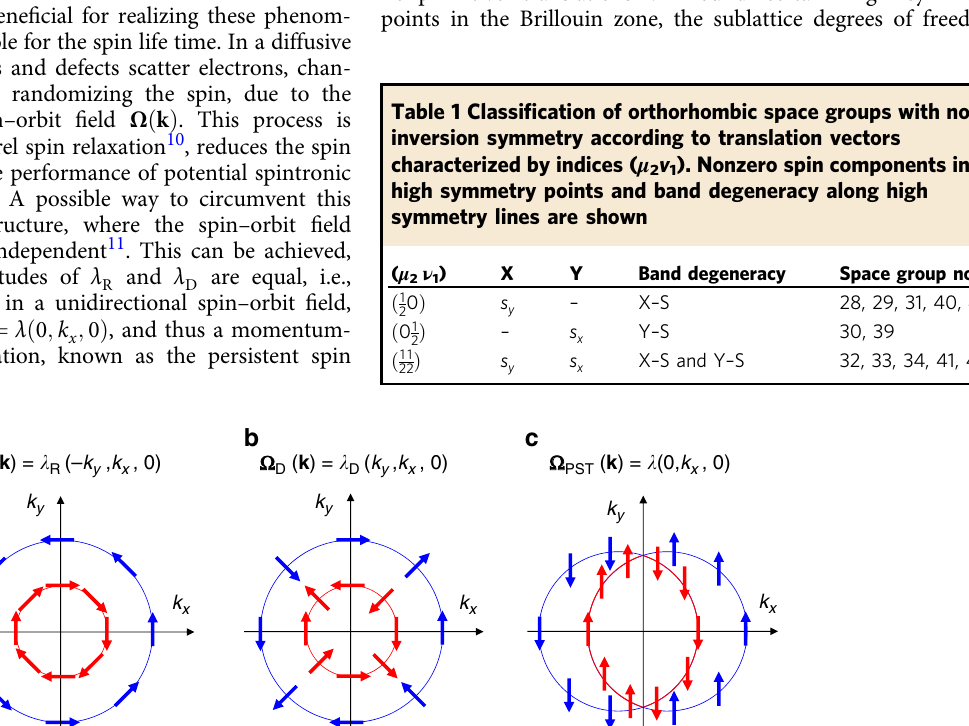
Table 1 Classi fi cation of orthorhombic space groups with